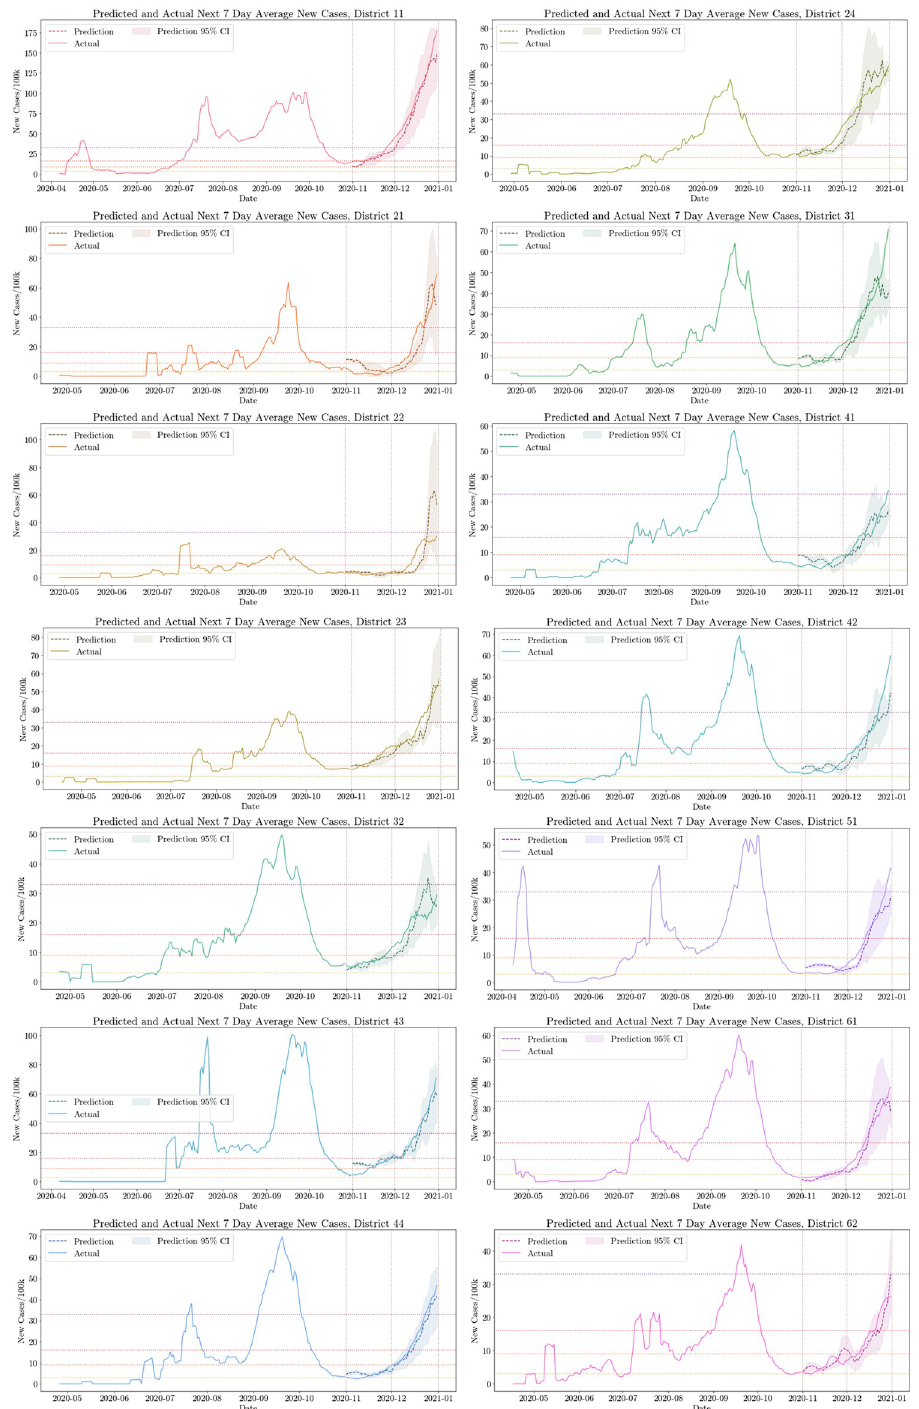
Fig 3. Predicted and actual next 7-day average new cases in the seven validation districts (left) and the seven test districts (right). Our predictions, made a week in advance, are shown as a dashed, darker line. The 95% confidence interval, computed using the past 14-day average standard deviation in predicted new cases, is shown in gray shading. Vertical dotted lines delineate the separate prediction intervals of November and December. The lower bound of Tiers 2–5 used for classifying the level of epidemic severity from Table 1 are shown as horizontal dotted lines.